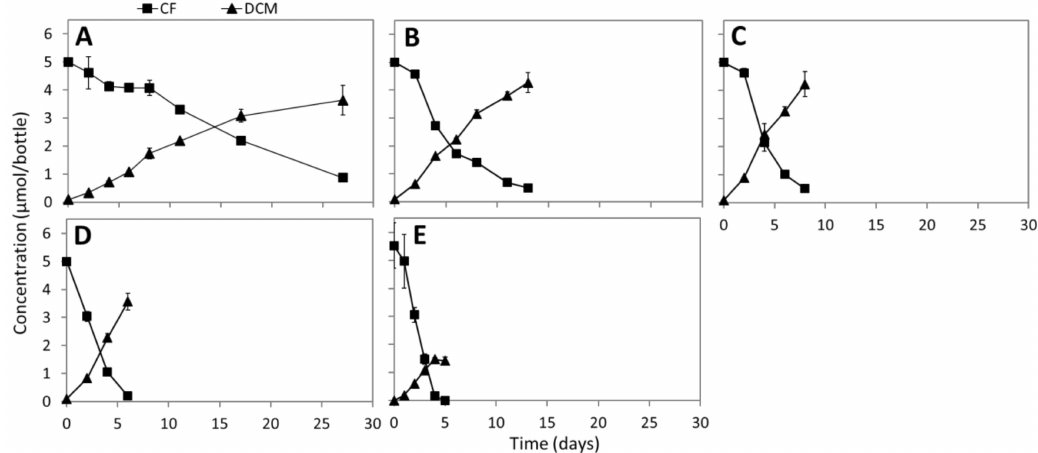
Figure 2. CF transformation in enrichment cultures amended with 0.04 ( A ), 0.4 ( B ), 0.8 ( C ), 1.6 ( D ), and 4 µ M ( E ) vitamin B 12 . Points and error bars represent the average and standard deviation of samples taken from duplicate